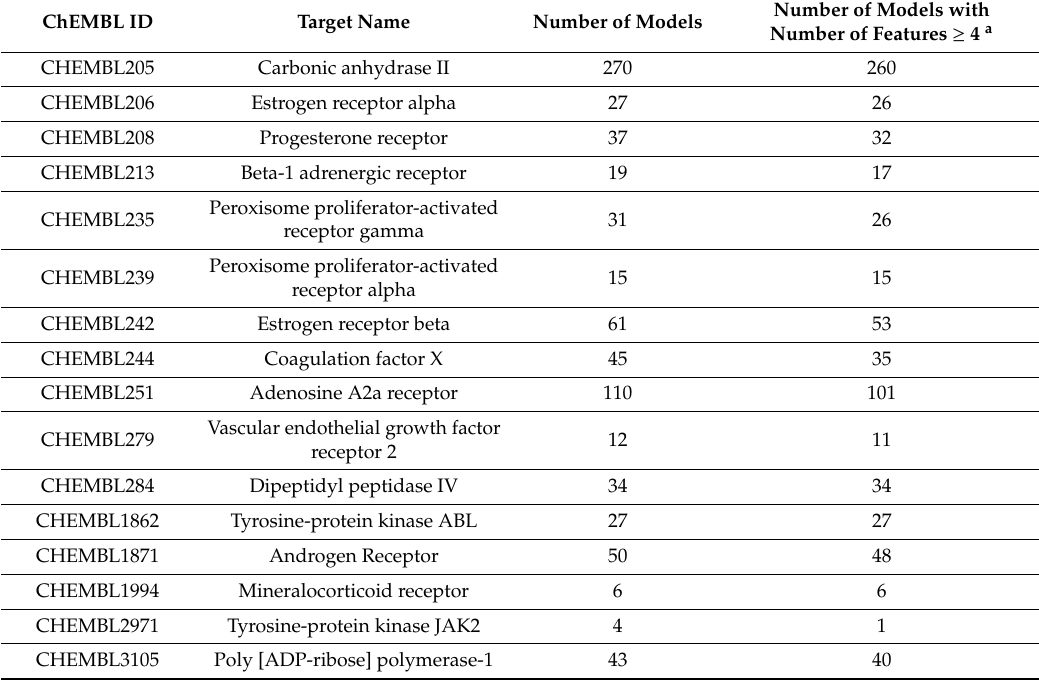
Table 2. The number of models generated for individual